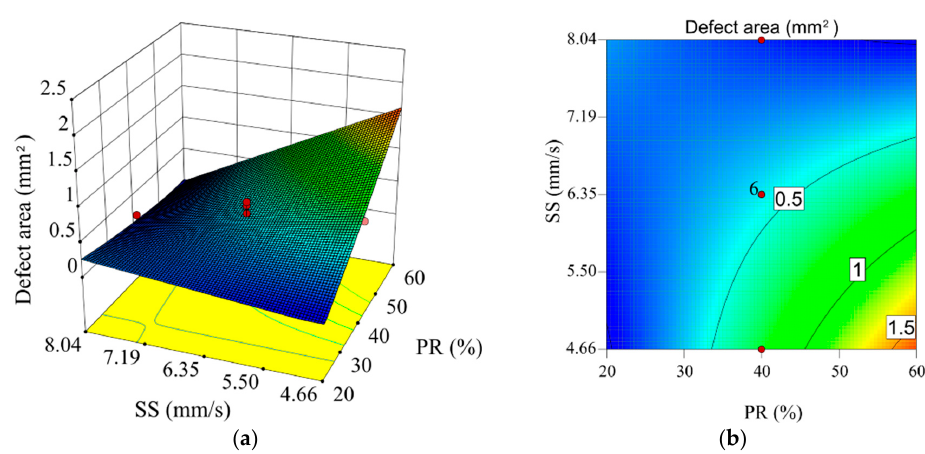
Figure 12. ( a ) 3D response surface showing the influence of scanning speed and TiC powder ratio on defect area; ( b ) Contour line of the response surface.